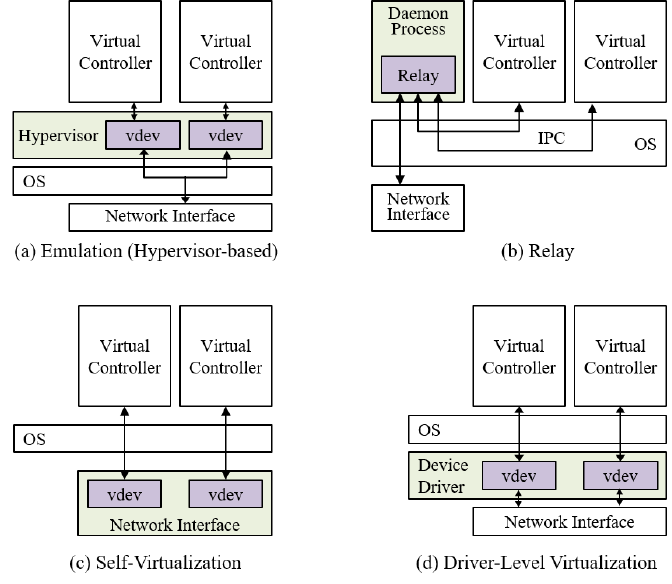
Figure 1. Alternatives for network interface